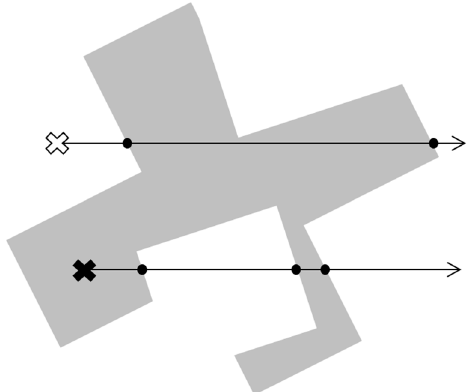
Figure 7. A simple example showing the application of the even–odd rule algorithm to determine that the white cross and the black cross are outside and inside the polygon region, respectively.